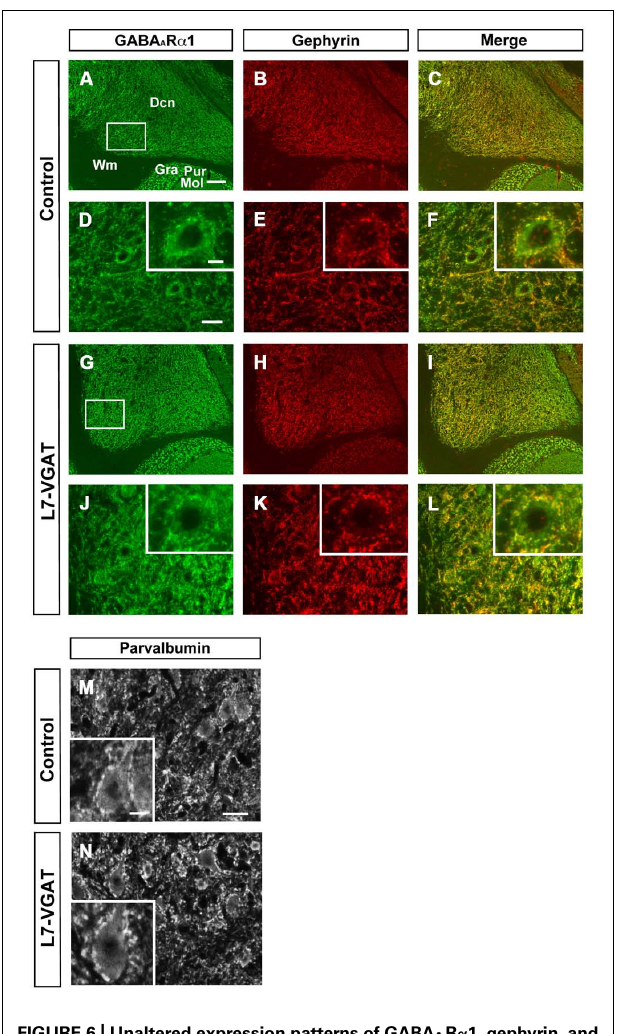
FIGURE 6 | Unaltered expression patterns of GABA A R α 1, gephyrin, and parvalbumin expression in the L7-VGAT DCN. Immunohistochemical staining for GABA A R α 1 (A,D,G,J ; green), gephyrin ( B,E,H,K ; red), and parvalbumin (M,N) was performed on coronal sections of the cerebella of 40-week-old mice.The DCN of control (A–F,M) and L7-VGAT (G–L,N) mice are shown. Areas surrounded by white rectangles in (A) and (G) are shown in (D) and (J) , respectively.The insets in (D–F,J–L,M,N) illustrate typical somata for each area. (E,F) and (K,L) shows the areas that are identical to those in (D) and (J) , respectively. Merged images of (A,D,G,J) and (B,E,H,K) are shown in (C,F,I,L) . Scale bars represent 100 μ m (A) , 20 μ m (D,M) , and 10 μ m (inset of D,M ). Dcn, deep cerebellar nucleus; Gra, granule cell layer; Pur, Purkinje cell layer; Mol, molecular layer; andWm, white